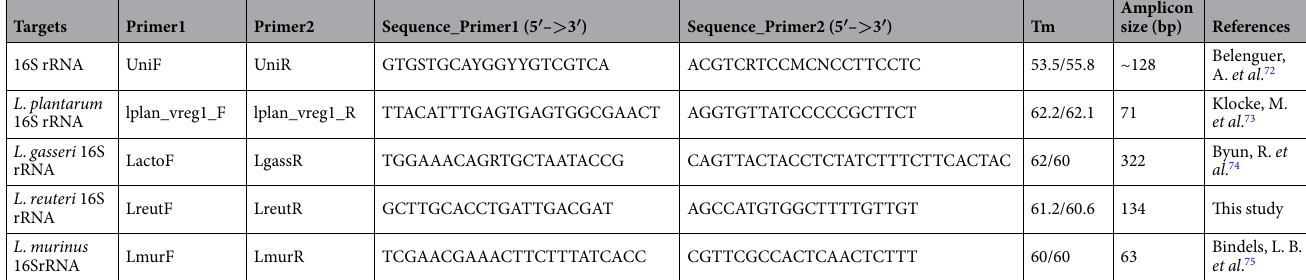
Table 1. Lactobacillus species-specific real-time PCR primers used in the